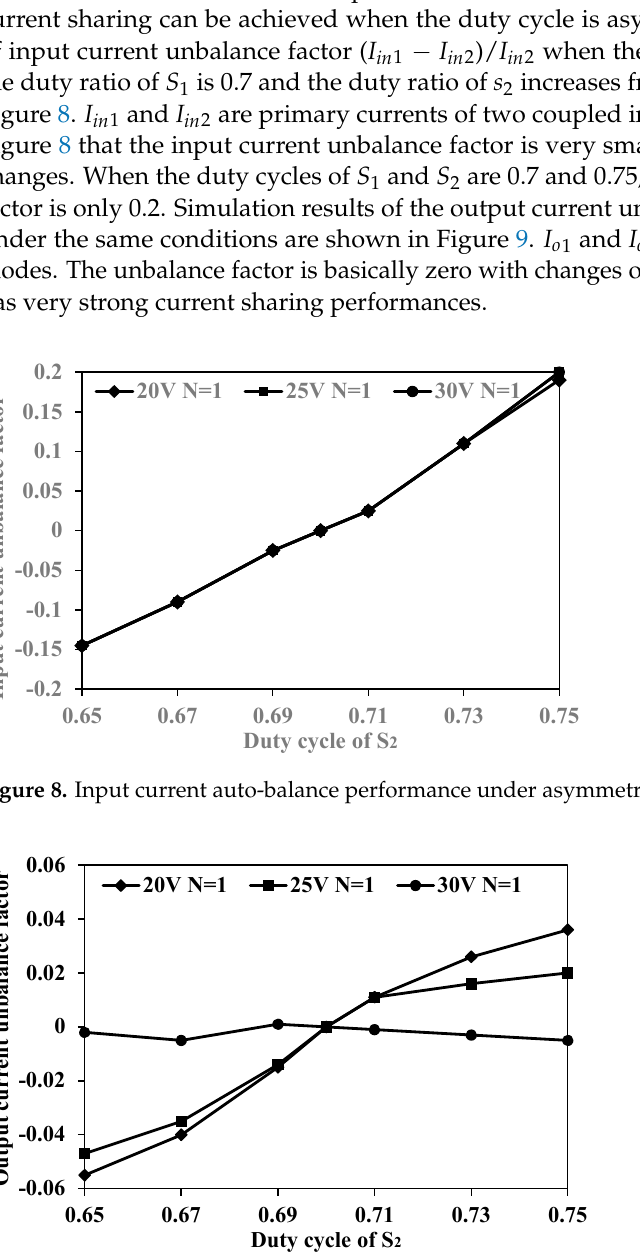
Figure 9. Output current auto-balance performance with asymmetrical duty cycle.